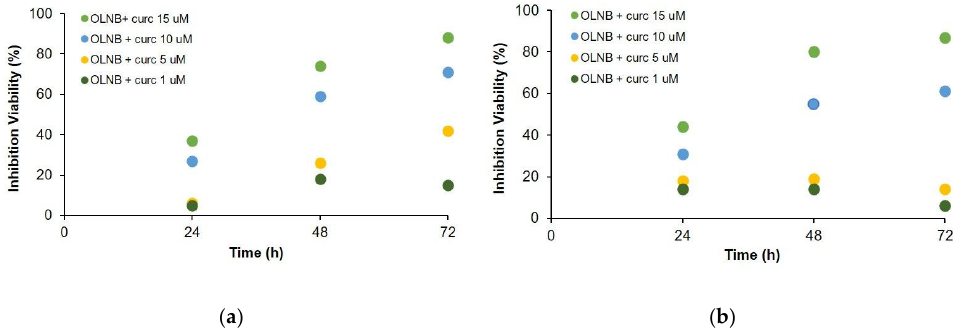
Figure 5. Percentage of inhibition of viability: ( a ) PC-3 tumor cells; ( b ) DU-145 tumor cells.